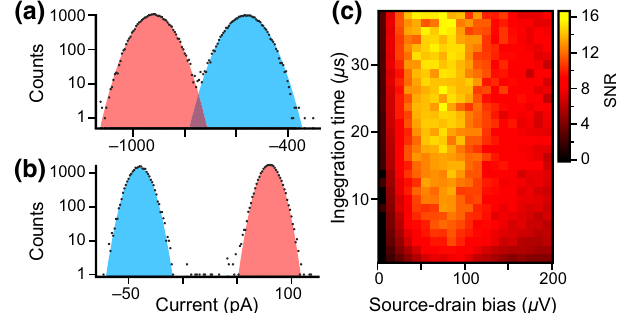
FIG. 3. Readout histograms and the SNR as a function of time and the bias amplitude. (a) Log-scale histograms of the DCS cur- rent (data in black), with Gaussian fits indicating singlet (blue) and triplet (red) readout signals, here with a total integration time of 980 ns. The thresholding of a distribution with this SNR (6.5) provides a bound on 1 − F BC ≥ 6 × 10 − 4 . (b) Histograms taken at an integration time of 40 μ s and with an additional measure- ment subtracted, giving an SNR of 15.5. This distribution bounds 1 − F BC (cid:2) 5 × 10 − 15 but other limiting effects (such as relaxation during measurement) are evident. (c) Histogram SNR as a func- tion of both the source-drain bias amplitude and the integration time. The SNR saturates as a function of the increasing inte- gration time due to 1 / f noise on the DCS potential. The SNR increases with the bias amplitude and then decreases beyond a critical